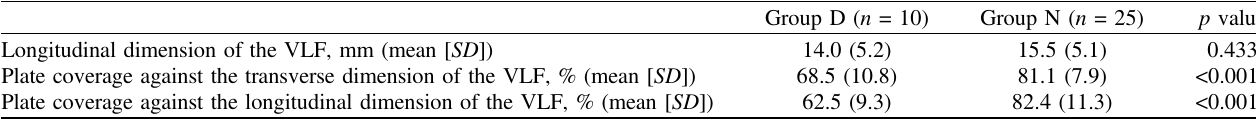
Table 2. Radiographic characteristics.